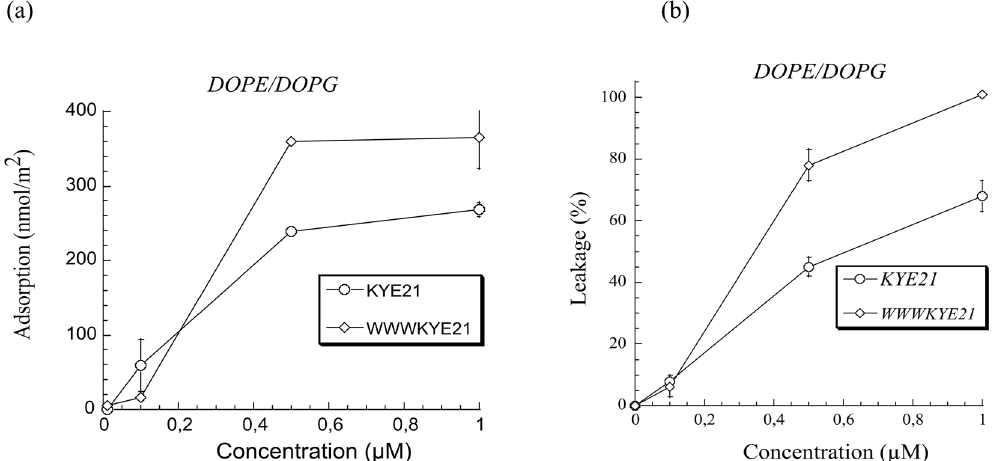
Figure 1. ( a ) Ellipsometry results on peptide binding to supported DOPE/DOPG (75/25 mol/mol) lipid bilayers in 10 mM Tris, pH 7.4. ( b ) Peptide-induced leakage of anionic DOPE/DOPG (75/25 mol/mol) liposomes in 10 mM Tris, pH 7.4. (n ≥ 2; For data points where error bars are not seen, these are smaller than the legend